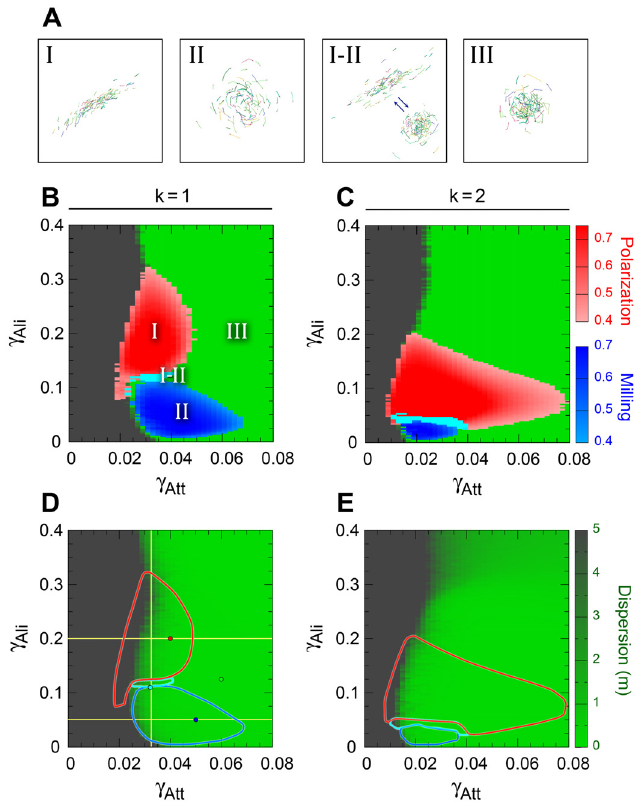
Fig 4. Impact of interaction strategies on collective states. (A) Spatial configuration of the characteristic collective states displayed by a group of N = 100 fish when each fish interacts with its most influential neighbor ( k = 1). (BC) Phase diagrams showing four distinct behavioral regions: S CHOOLING (I) in red, with highly polarized group ( P > 0.4, M < 0.4), M ILLING (II) in blue, with low polarized group frequently displaying milling behavior ( P < 0.4, M > 0.4), S WARMING (III) in green, with small polarization and milling ( P < 0.4, M < 0.4), intermittence between schooling and milling (I-II) in cyan ( P > 0.4, M > 0.4) when fish interact with their most influential neighbor (B) and their two most influential neighbors (C). Gray regions correspond to excessively weak or excessively strong interactions, giving rise to fish dispersion ( D > 5 m). Boundary between high dispersion region and swarming region (both in uniform color) is determined by the transition layer from high to low dispersion shown in Panels D and E. (DE): Contour lines of the collective behavior phases shown in Panels (BC), overlaying the dispersion map, from green (low dispersion) to gray (high dispersion). In panel (D), small circles denote the combination of parameters ( γ Att , γ Ali ) corresponding to the time series shown in Fig 5, and yellow lines denote the vertical and horizontal cuts described in Fig 6. Social interaction ranges are l Att = l Ali = 0.28 m, intensity of random fluctuation (noise) is γ R =